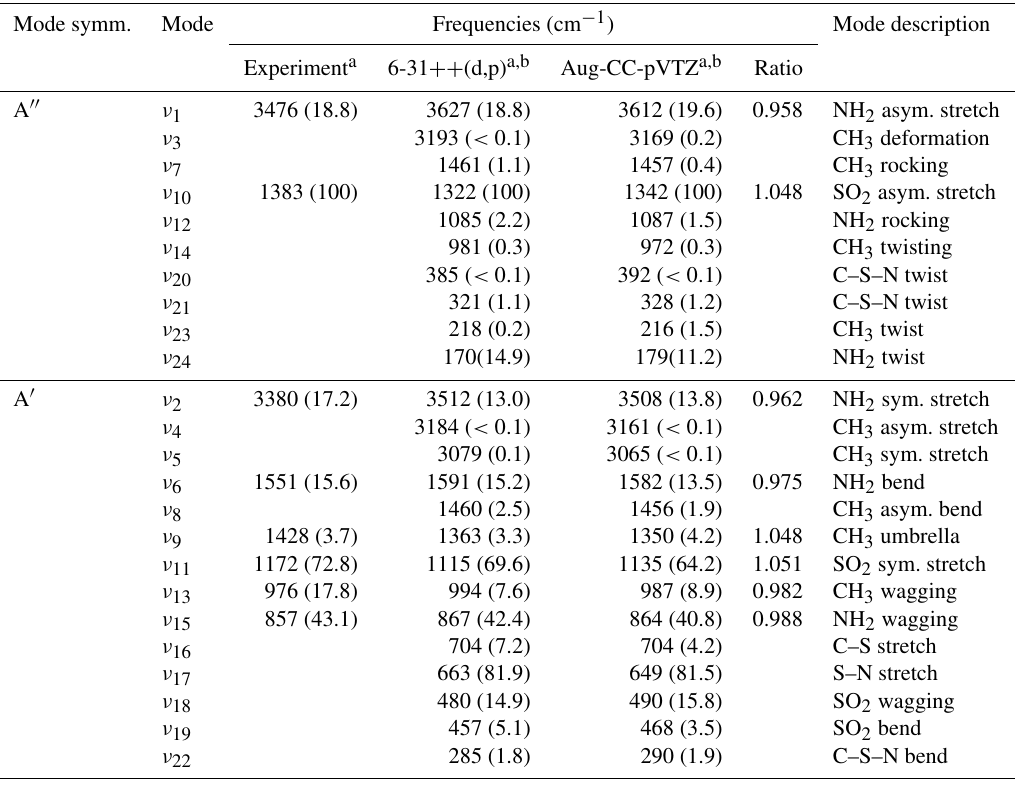
Table 1. Experimental and calculated vibrational wavenumbers for MSAM. Mode symm.